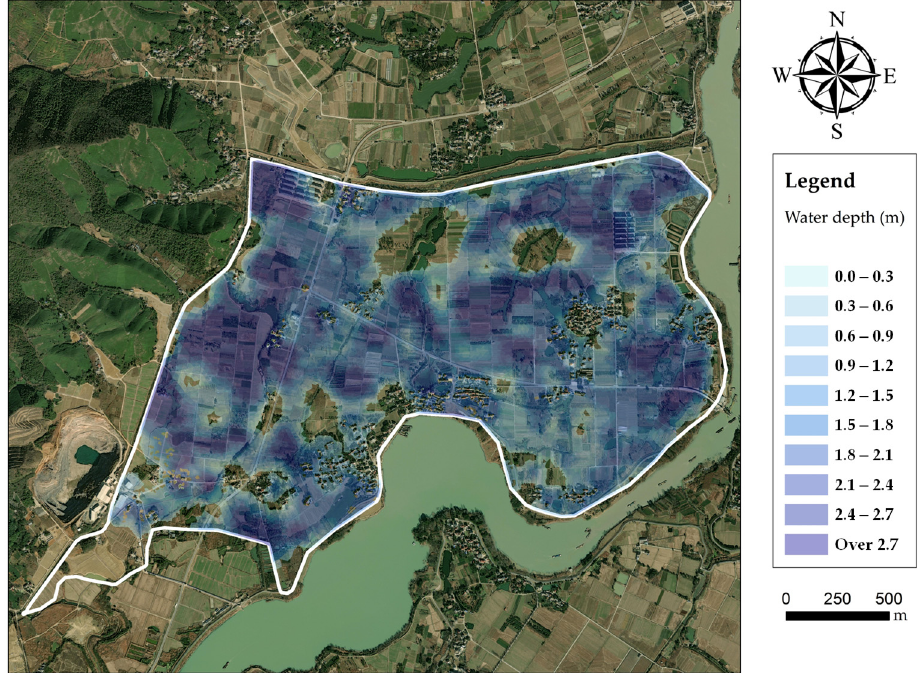
Figure 8. Inundated areas in flood scenario of 20-year return period.